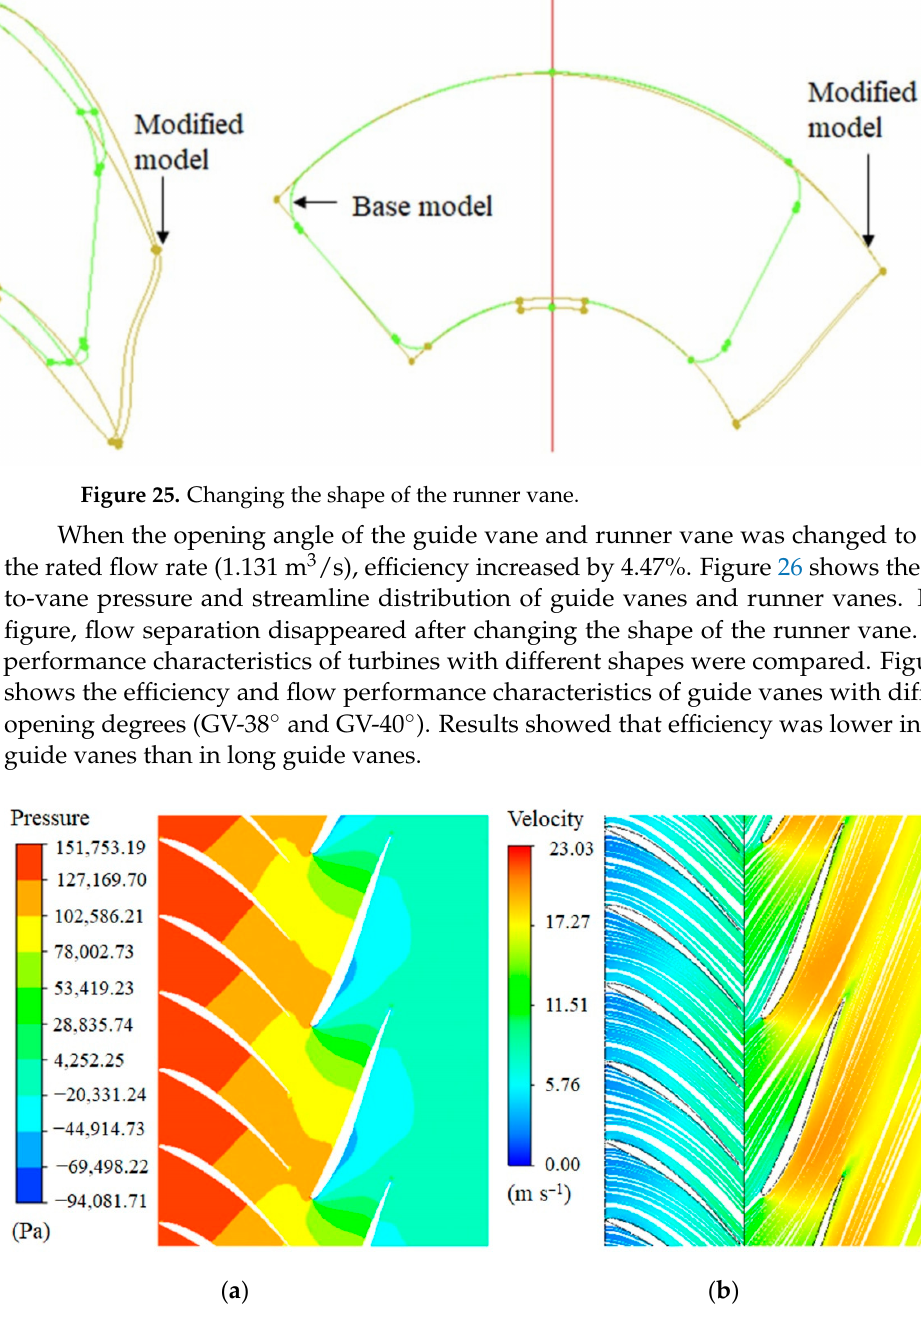
Table 10. Performance characteristics according to runner vane shape (H = 14.84 m).